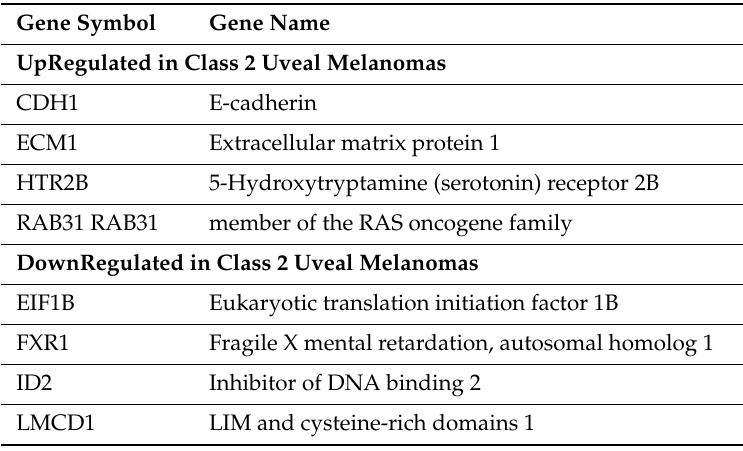
Table 1. Genes included in the 15-gene expression